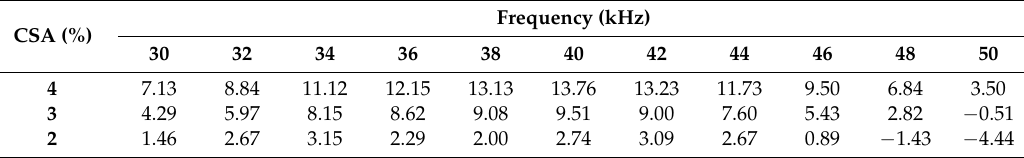
Table 3. Achieved SNR from defect signal in each test case (in